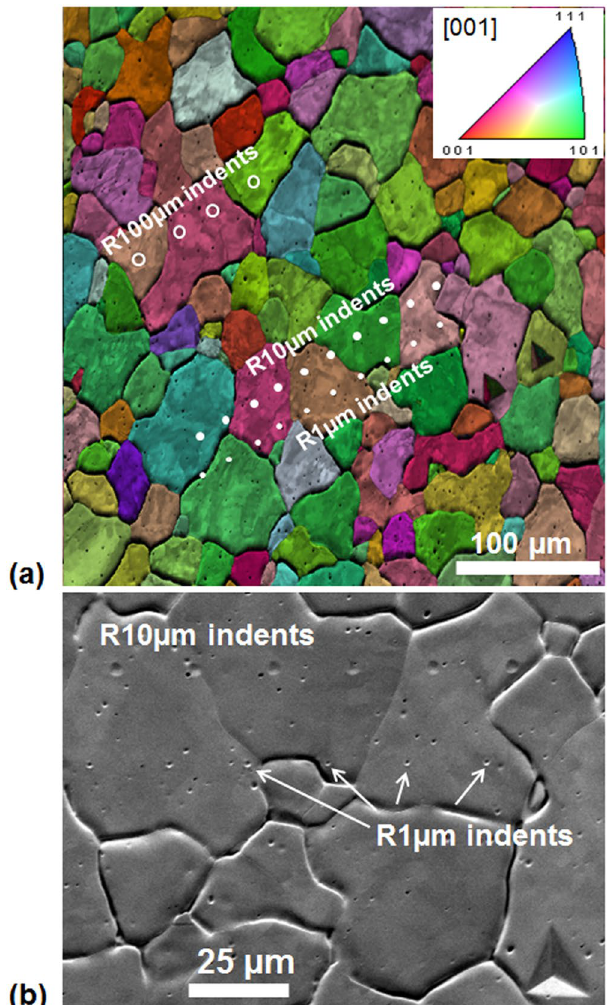
Figure 2. ( a ) EBSD image quality map with superimposed grain coloring using the inverse pole figure (IPF, shown in inset) scheme, showing the indent locations for different indenter sizes of 1, 10 and 100 µ m radii. ( b ) A magnified SEM image showing the indent locations for the 1 and 10 µ m radii